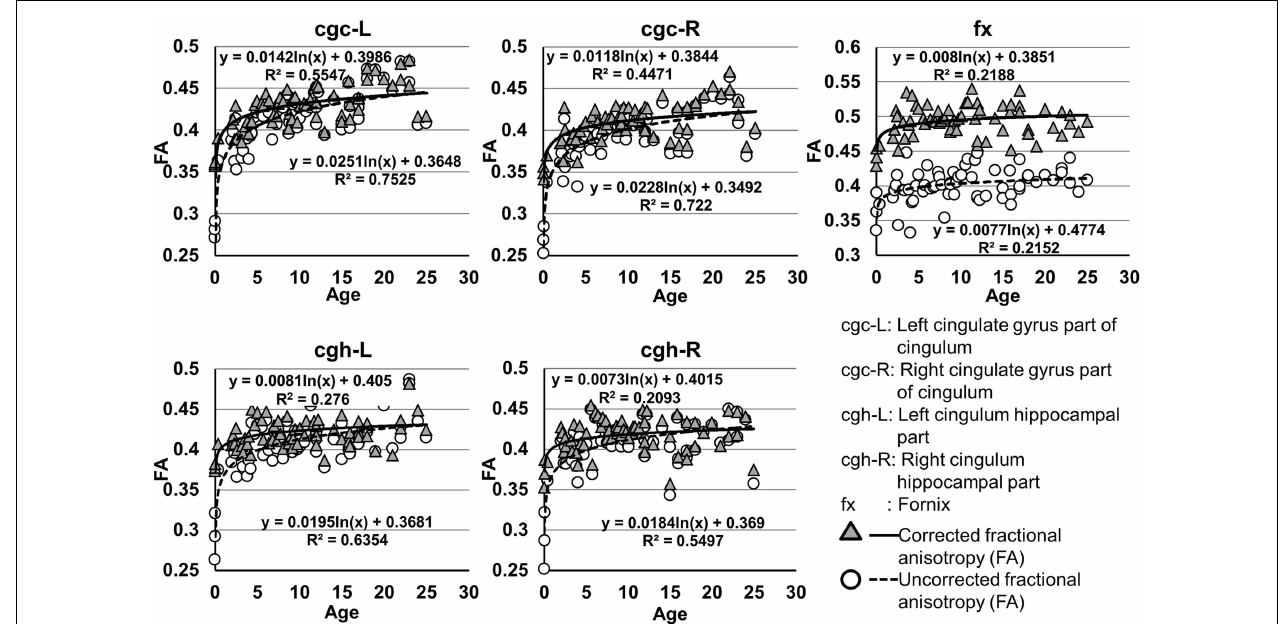
FIGURE 3 |Age-dependent changes of uncorrected and corrected fractional anisotropy (FA) measurements of limbic tracts . R 2 and fitting equations are listed in each panel.